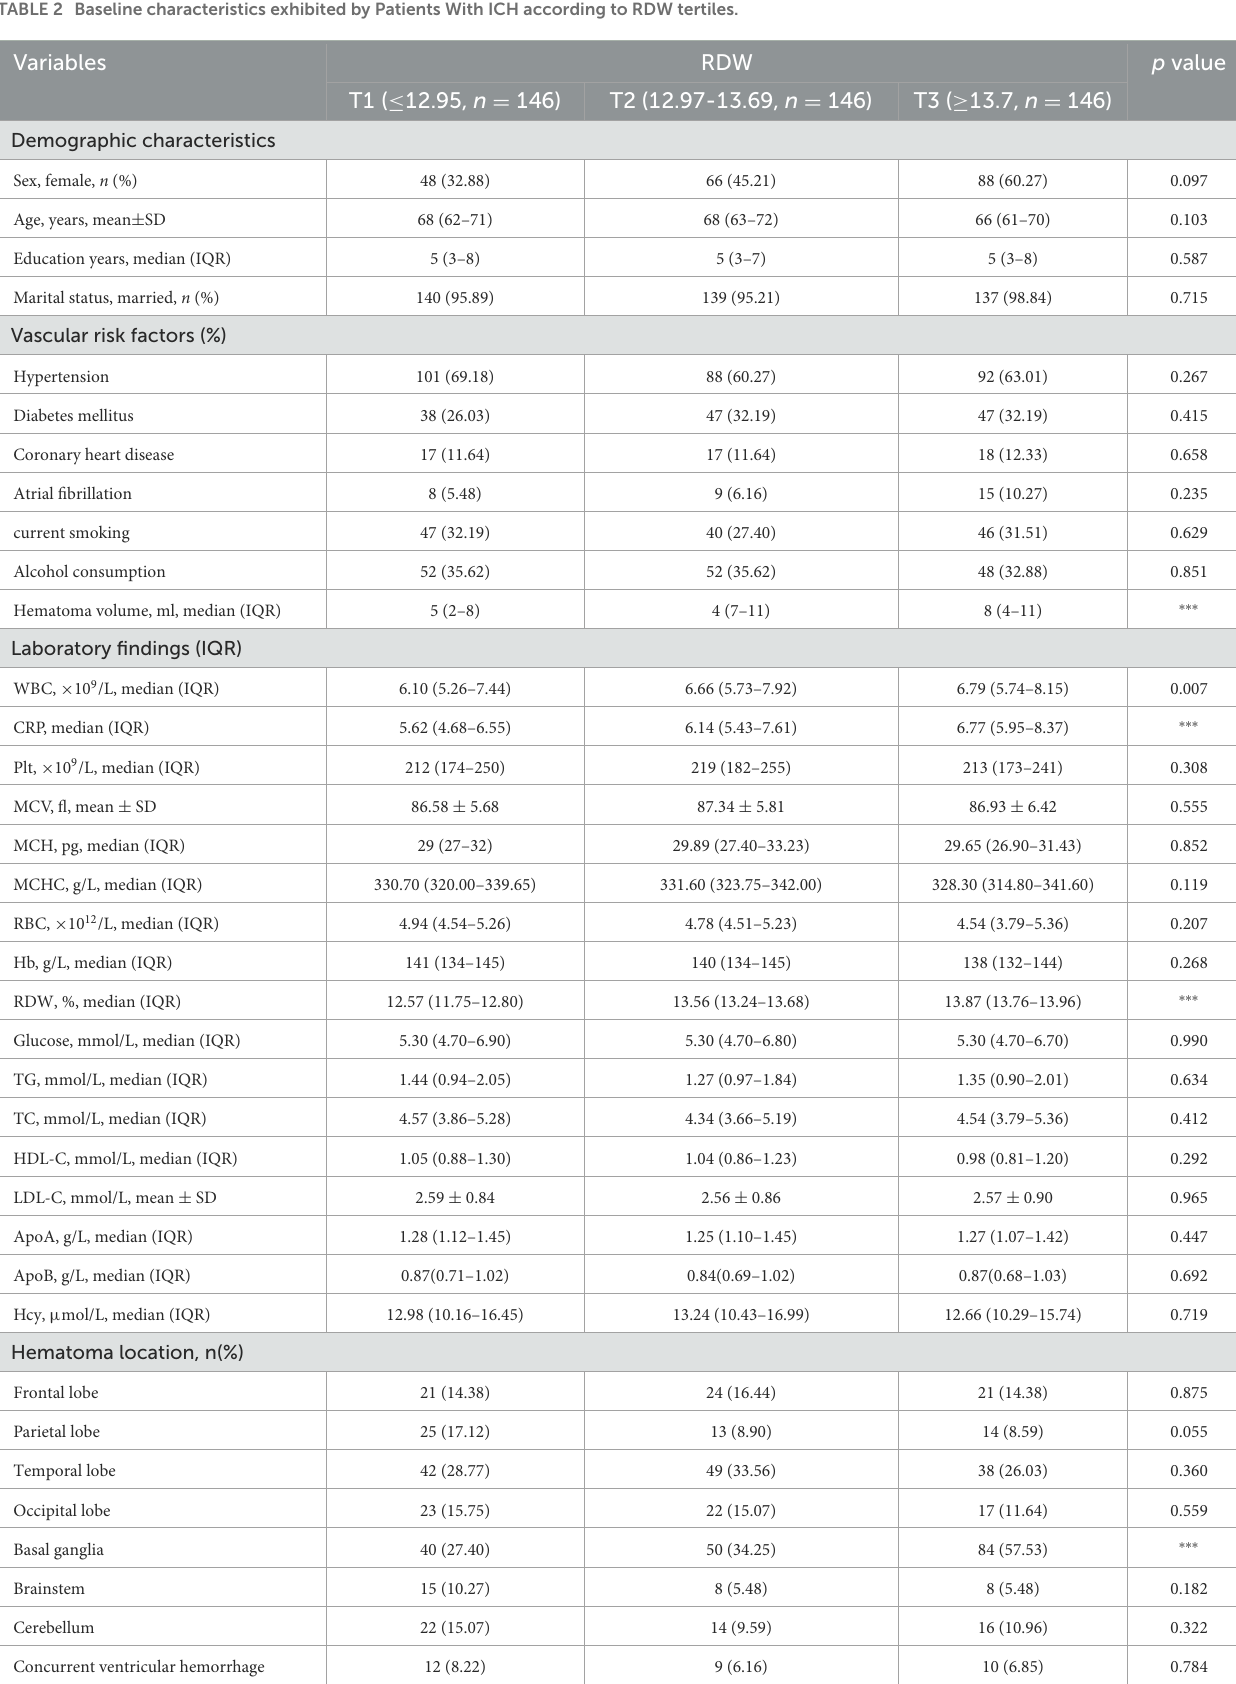
TABLE 2 Baseline characteristics exhibited by Patients With ICH according to RDW